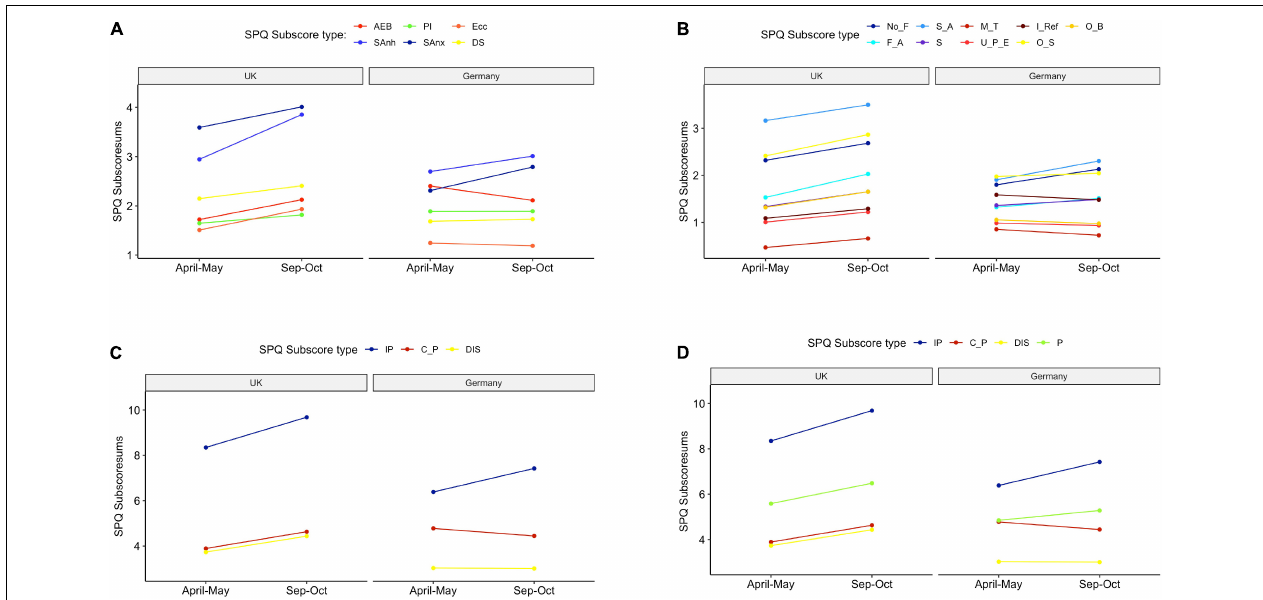
FIGURE 4 | Interaction plot shows different subdimension models across samples and countries. (A) Six-factor model by Davies (2017). AEB: Anomalous experiences and beliefs, SAnh: Social anhedonia, PI: Paranoid ideation, SAnx: Social anxiety, Ecc: Eccentricity, DS: Disorganized speech. (B) Nine-factor model by Raine (1991). No_F: No close friends, F_A: Flattened/Constricted affect, S_A: Social anxiety, S: Suspiciousness, M_T: Magical thinking, U_P_E: Unusual perceptual experience, I_Ref: Ideas of Reference, O_S: Odd speech, O_B: Odd behavior. (C) Three-factor model by Raine et al. (1994). IP: Interpersonal,